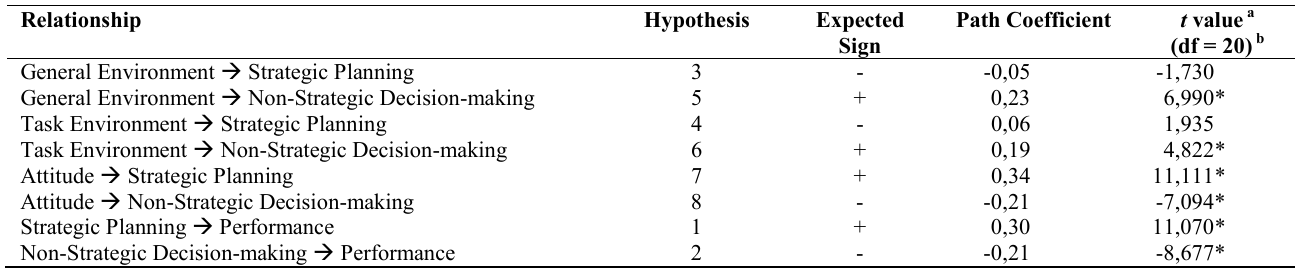
Table 5: PLS estimates of the structural model